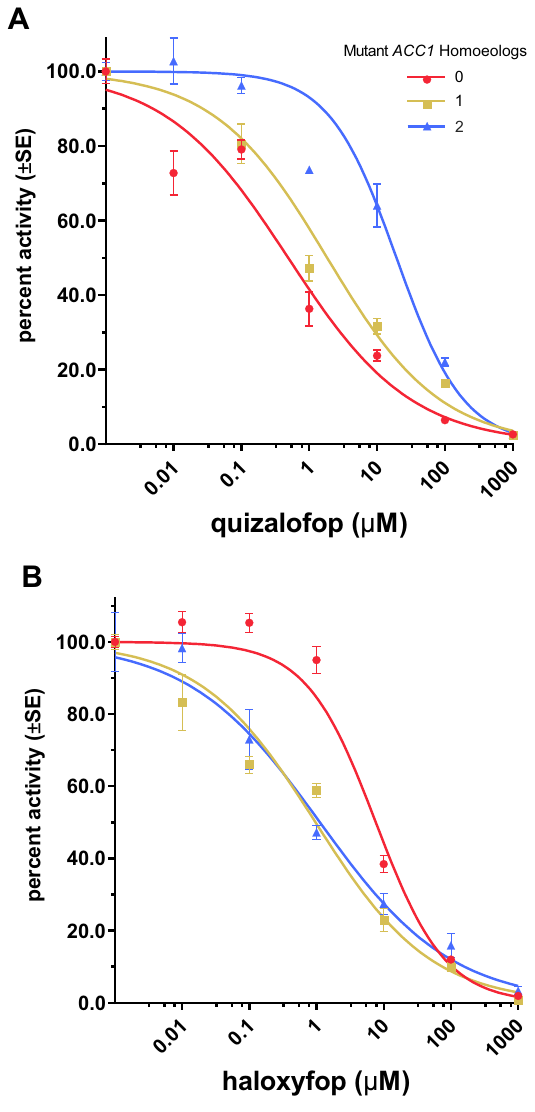
Figure 3. Models a of quizalofop ( A ) and haloxyfop ( B ) herbicide dose effects on ACCase activity by genotype b . a Genotype refers to the number of homozygous mutations in ACC1 that result in a A2004V amino acid substitution, with up to three possible on group 2 chromosomes in hexaploid wheat (2n = 6x). These mutations result in quizalofop-resistant wheat ACCase. b Activity values (DPM) normalized to percent untreated controls and transformed with Box-Cox transformation per genotype for each herbicide. The dose effect of each herbicide is modeled with a 2-parameter log-logistic